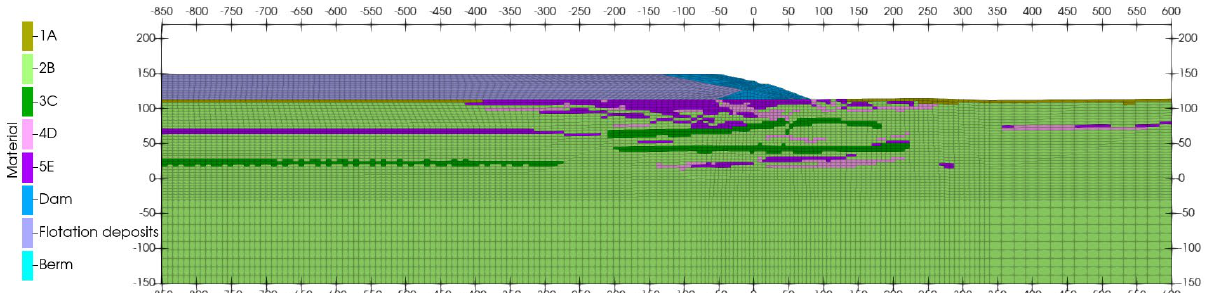
Figure 4: Geometry and mesh of numerical model at computational step 120.